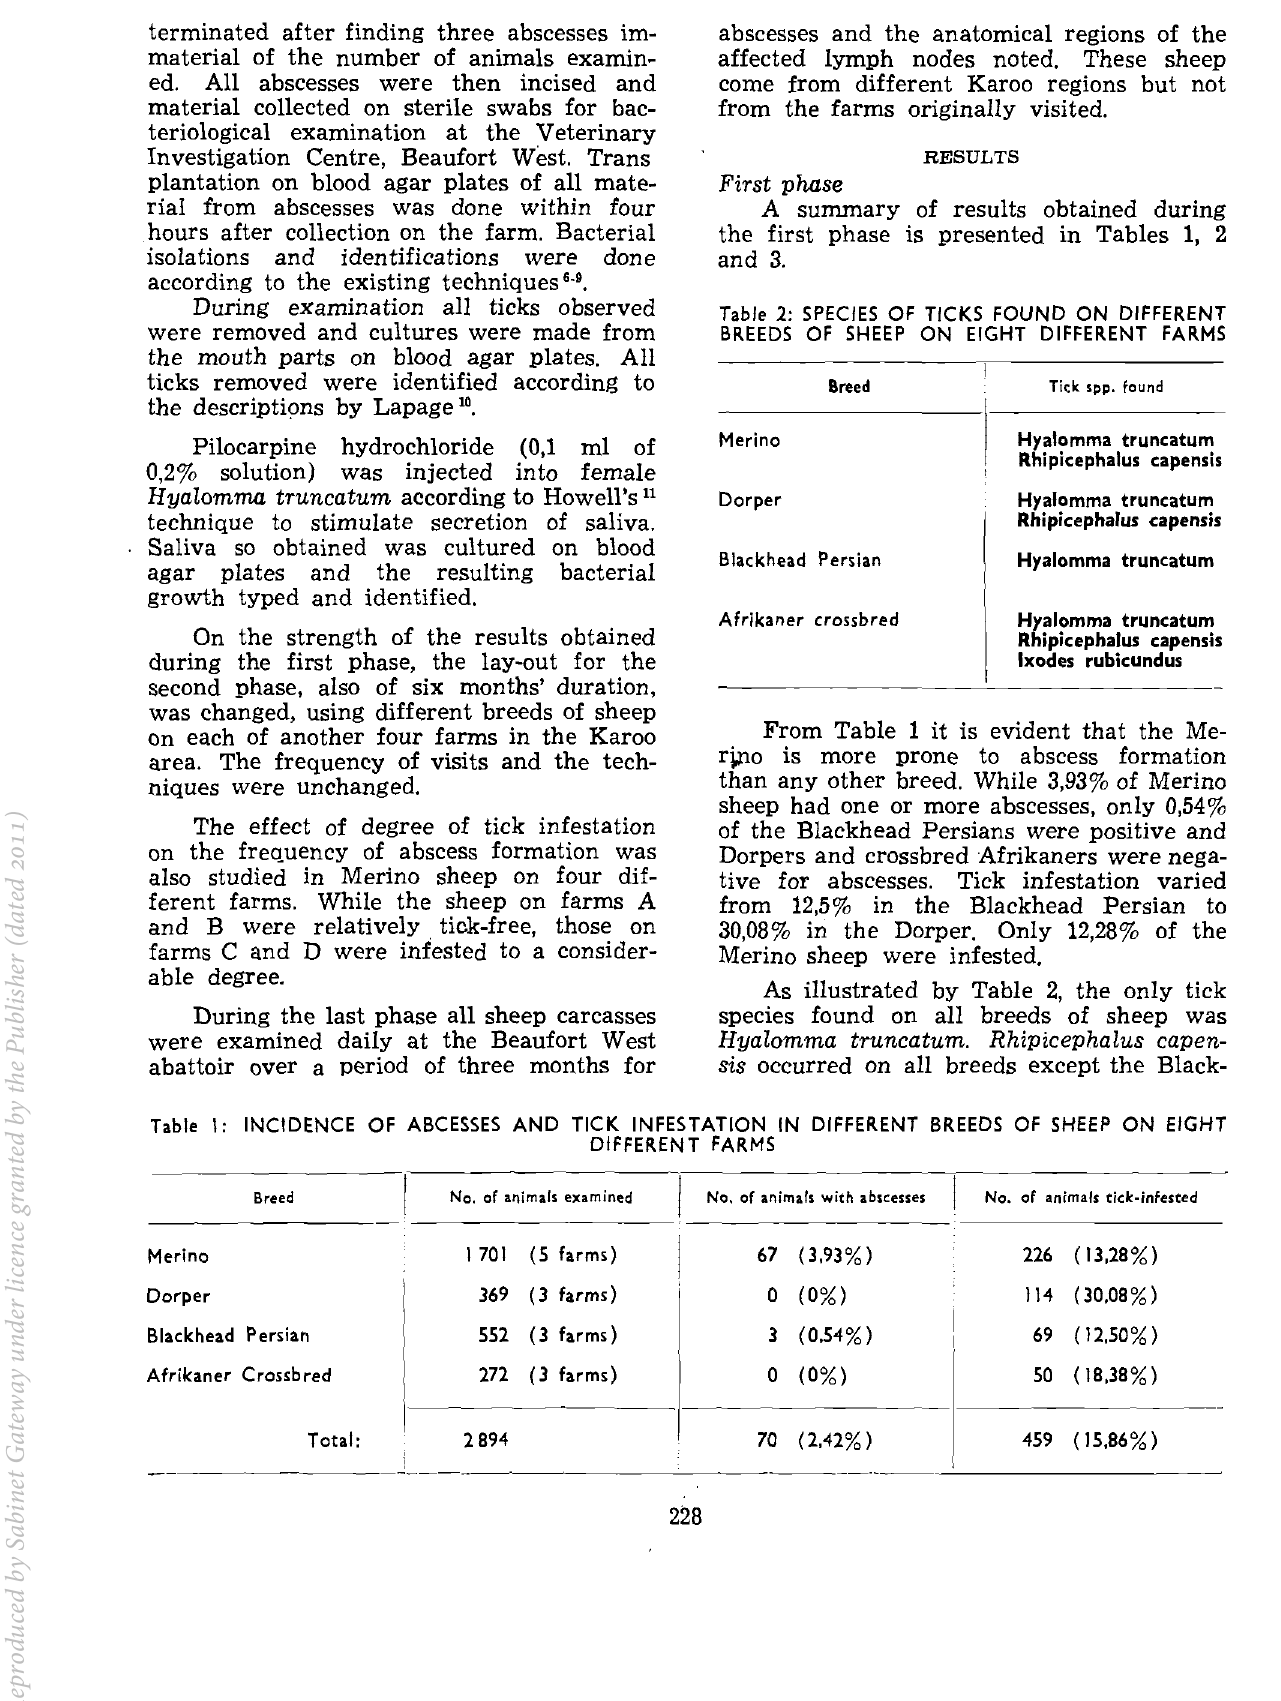
erino M orper D B